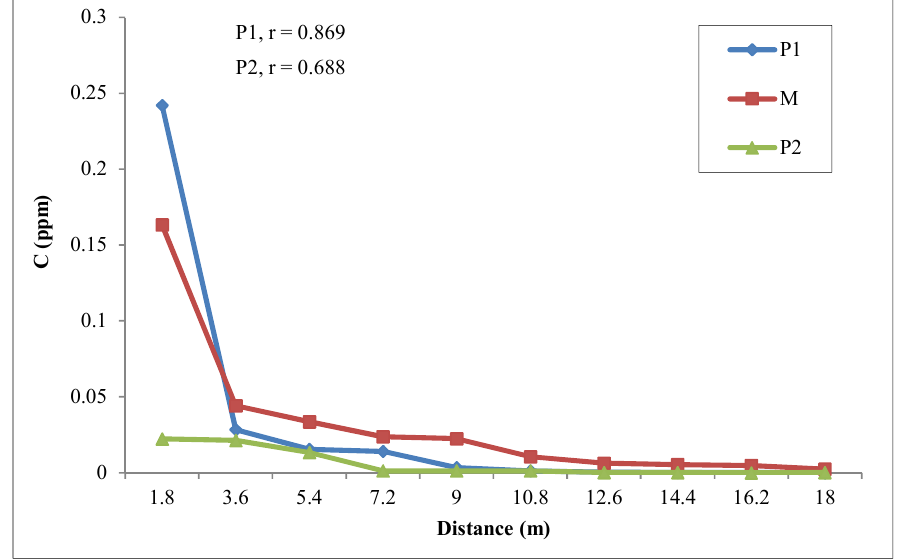
Figure 15. Measured and Predicted Concentrations against Distance for the month of